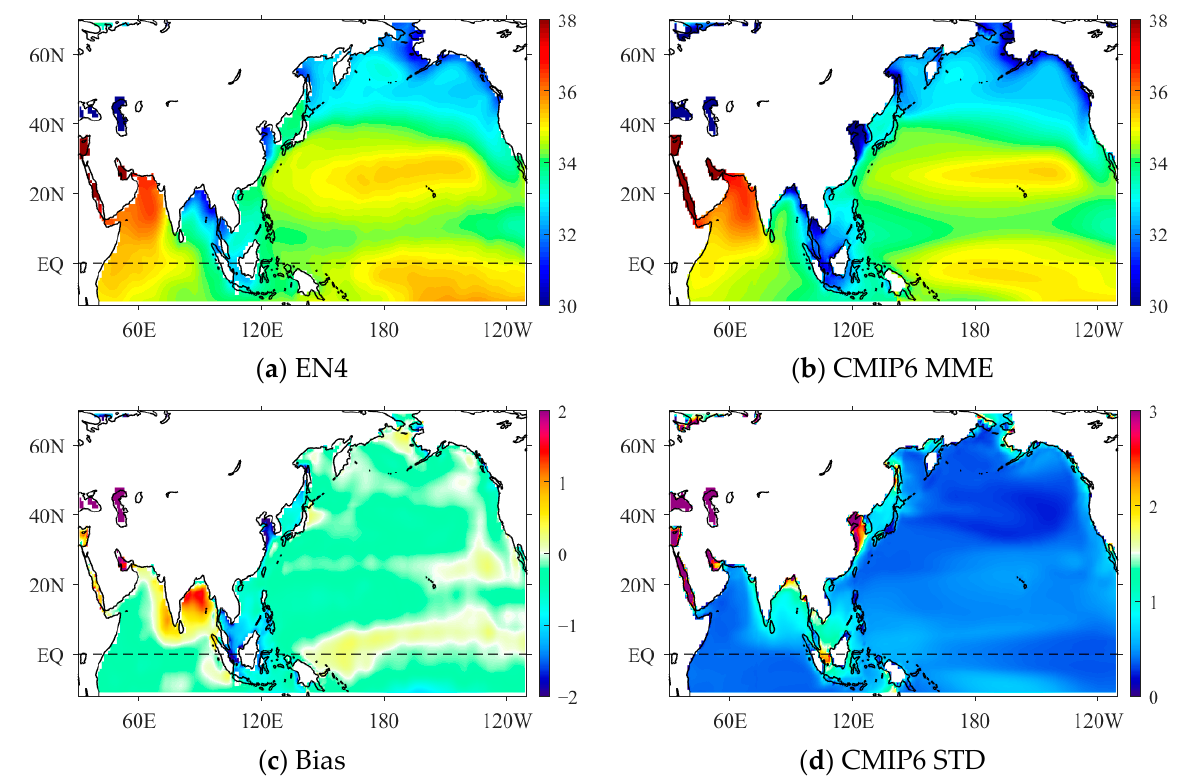
Figure 2. Observed and simulated annual mean sea surface salinity (SSS; unit: psu). ( a ) EN4; ( b ) multi-model ensemble mean (MME) of the CMIP6 models; ( c ) biases between the CMIP6 MME and EN4; ( d ) cross-model standard deviation of the simulated SSS in the CMIP6 models.